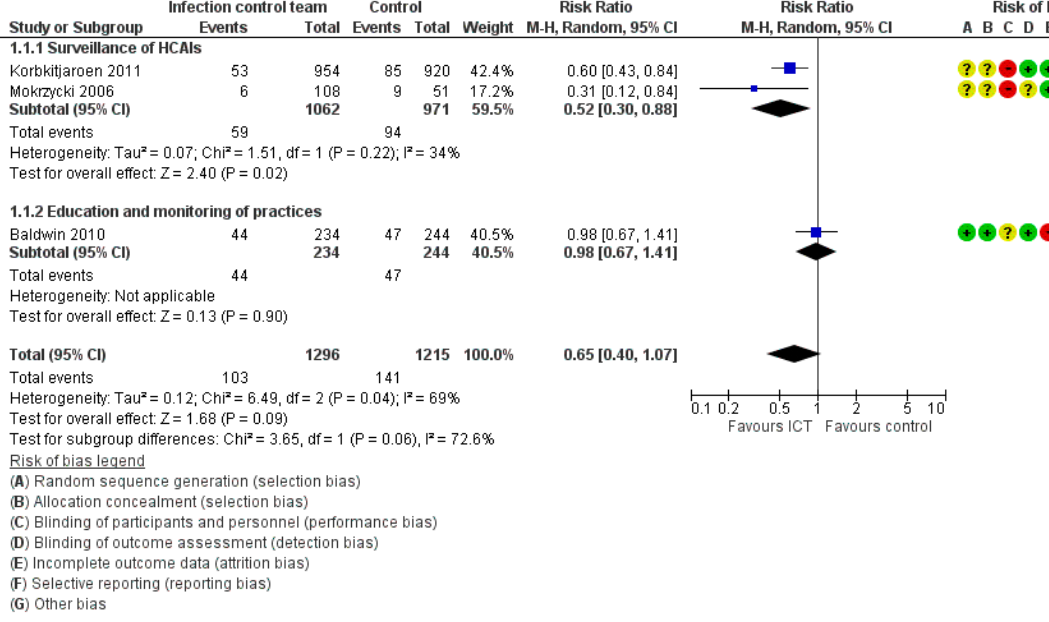
Figure 4. Meta-analysis for the incidence rate of HCAIs [25,28,31].